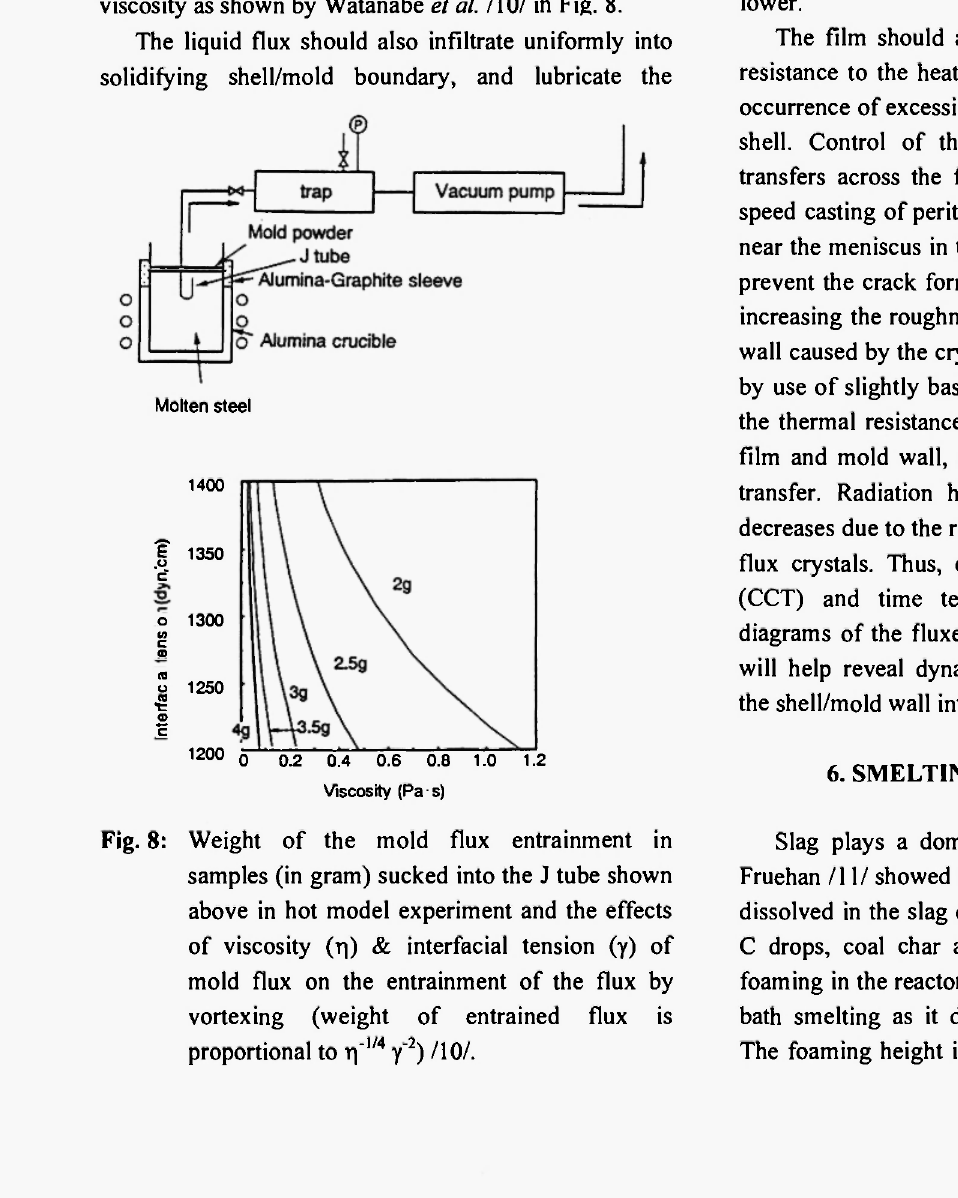
Fig. 8: Weight of the mold flux entrainment in samples (in gram) sucked into the J tube shown above in hot model experiment and the effects of viscosity (η) & interfacial tension (γ) of mold flux on the entrainment of the flux by vortexing (weight of entrained flux is proportional to η"" 4 γ" 2 )